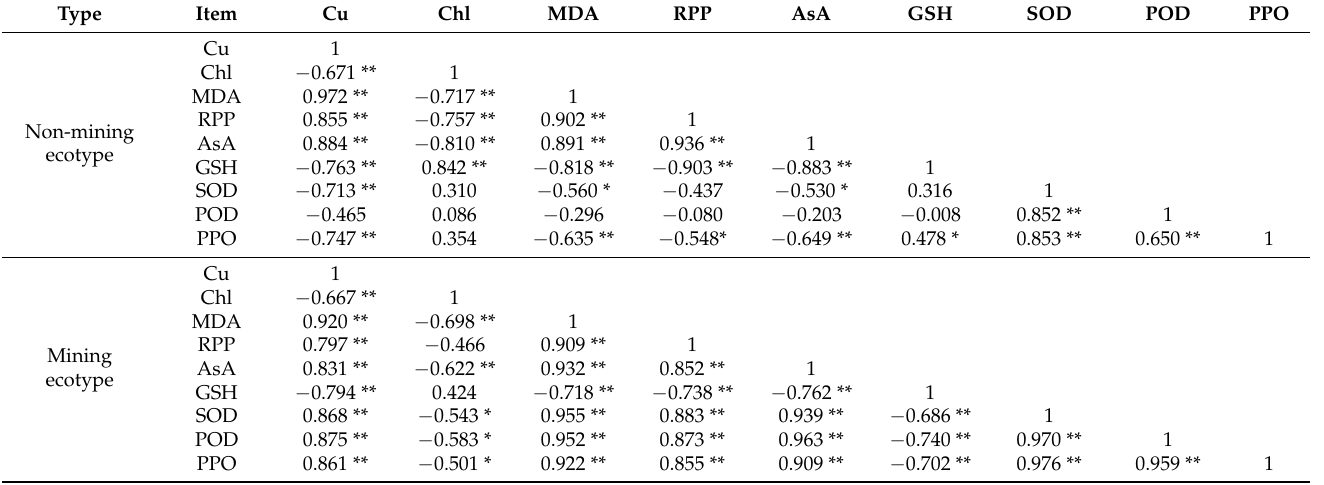
Table 3. Pearson product-moment correlation matrix for MDA, Cu concentrations and SOD, POD , PPO of Miscanthus floridulus